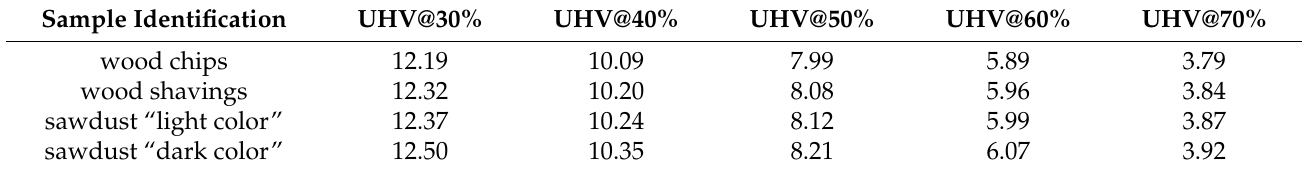
Table 5. Useful Heating Value (UHV, in MJ/kg) of different particle sizes at different moisture contents. Sample